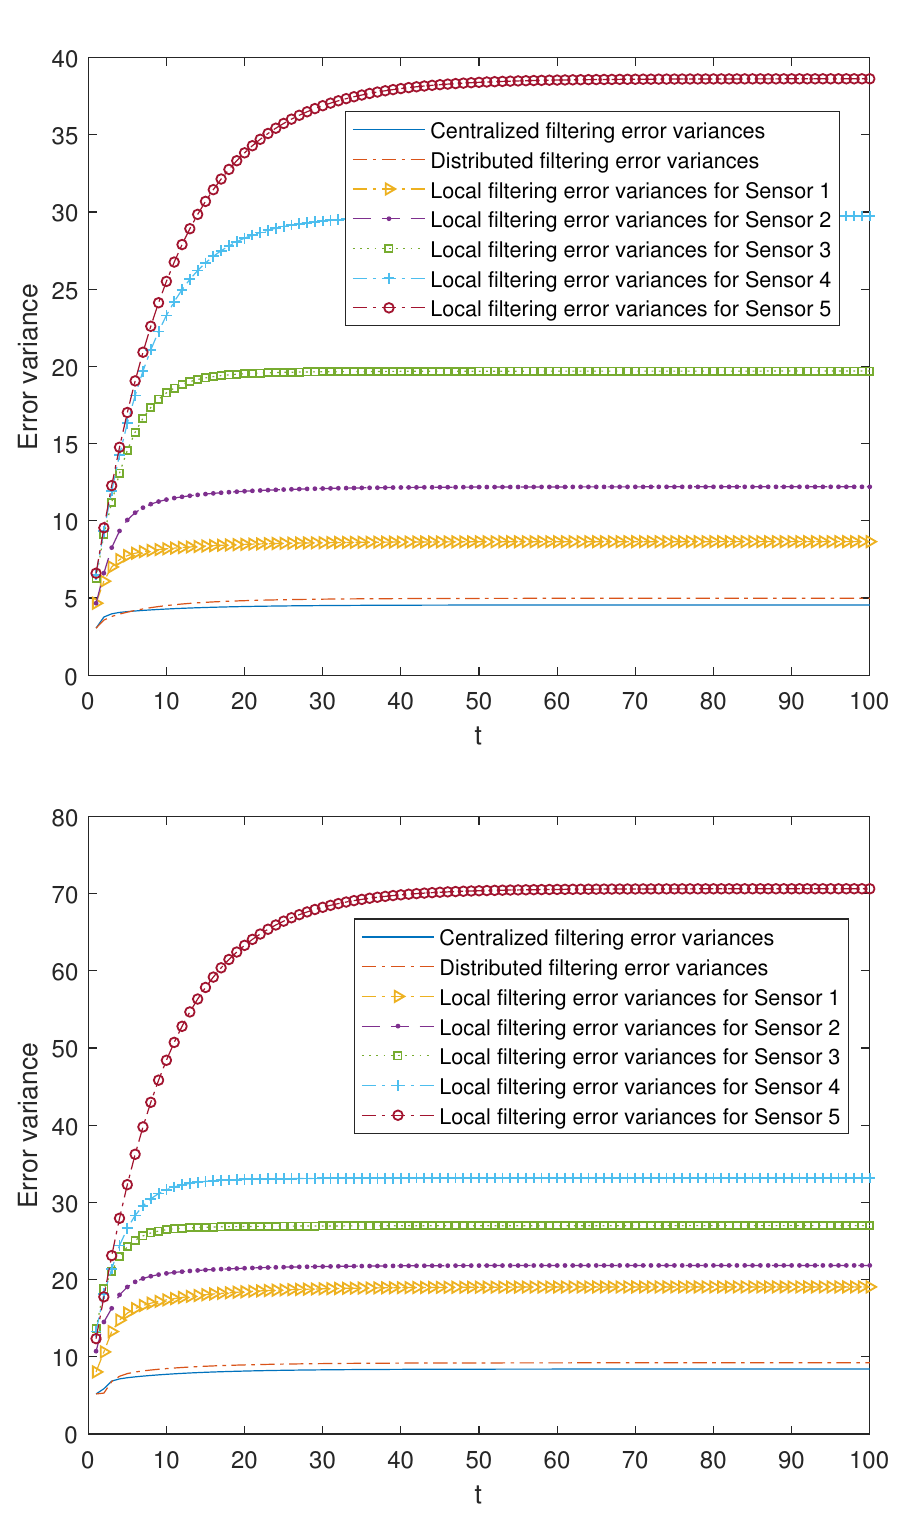
Figure 1. Filtering error variances in the T 1 -proper scenario ( top ) and T 2 -proper one ( bottom ). Our attention is focused on analyzing the accuracy of both centralized and distributed fusion filters in different situations concerning the observations produced by the sensors and in both T k -proper scenarios. For this purpose, we have considered the following cases with different values for the Bernoulli